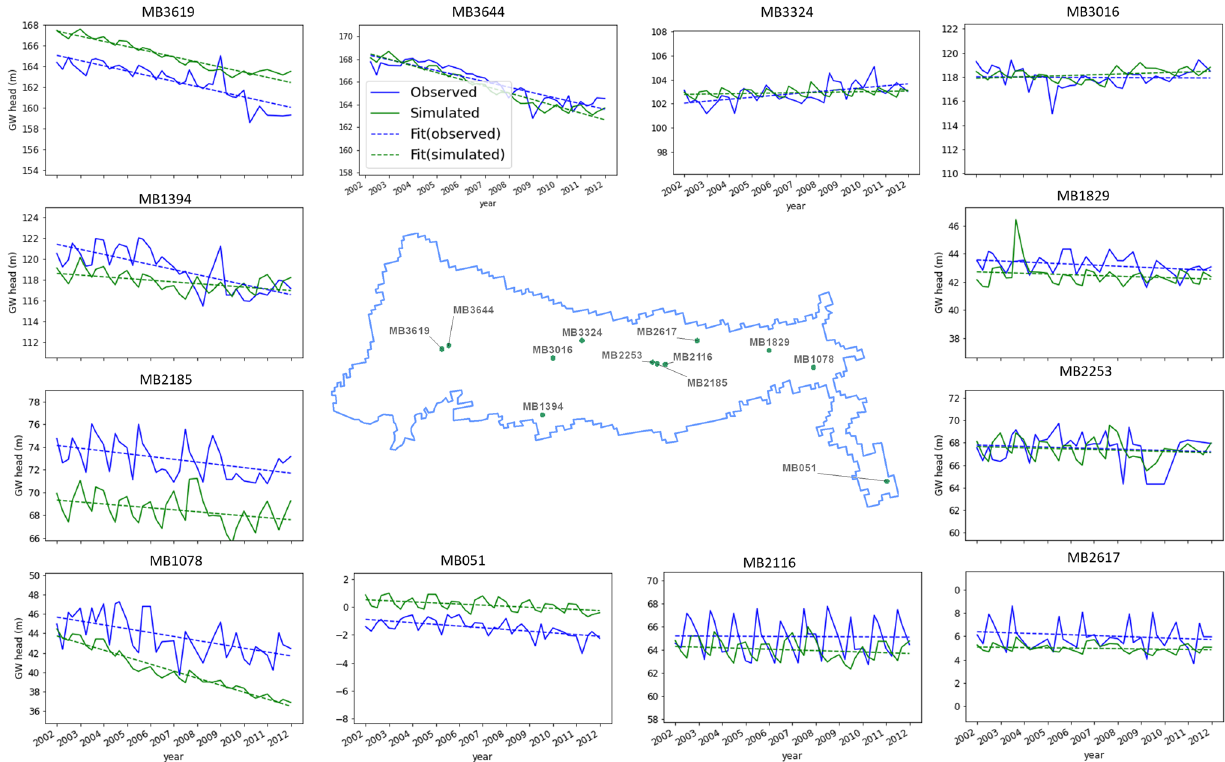
Figure 6. Observed and simulated groundwater heads at selected locations showing a wide range of trend types from steep declining (MB3619) to slightly increasing (MB3324)